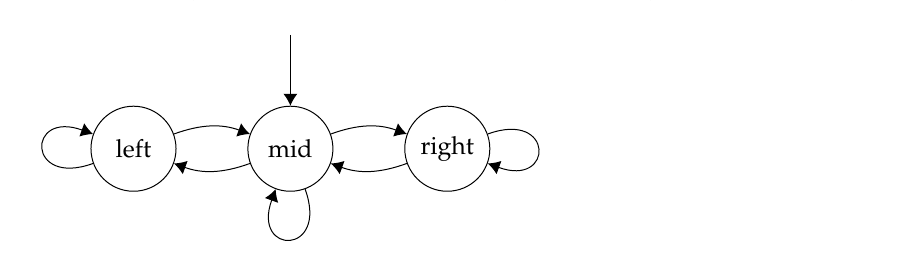
Figure 2. Agamewhereafinite-memoryNashequilibriumisrequiredtomodelan ω -regular specification. In this game, each player decides whether they want to go left or right. When